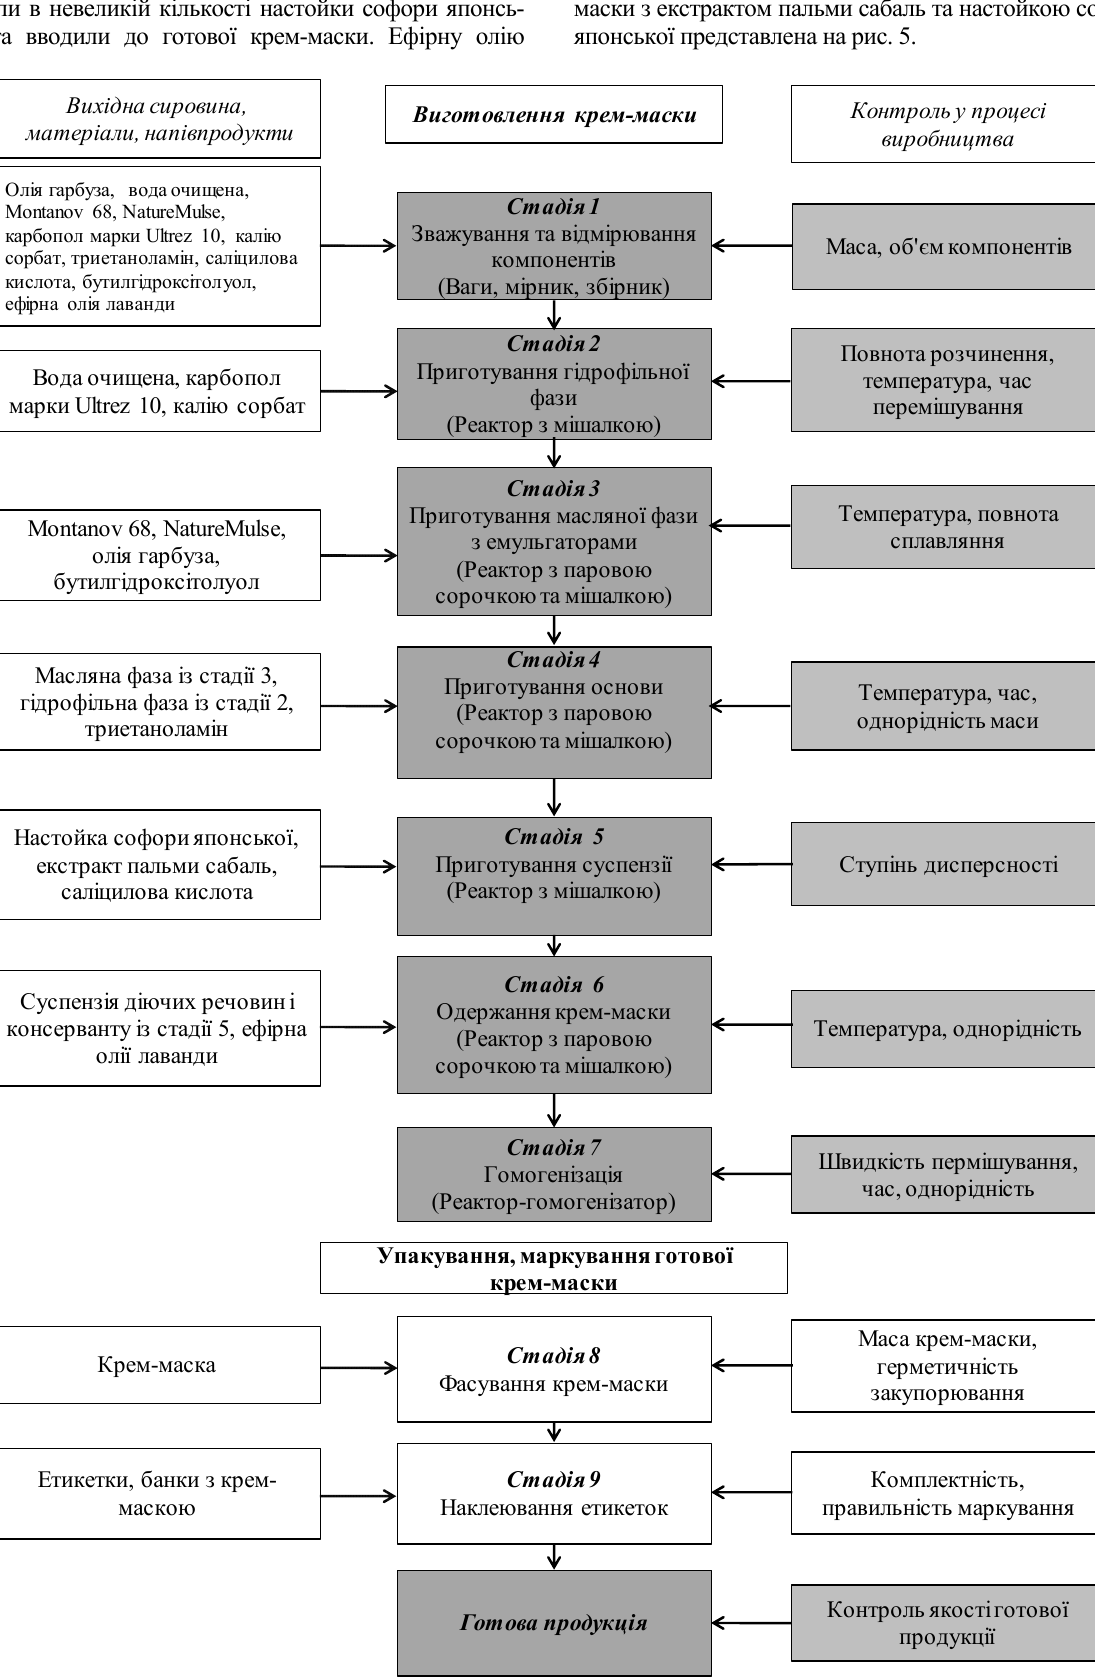
Рис . 5. Технологічна схема виробництва крем - маски з екстрактом пальми сабаль та настойкою софори